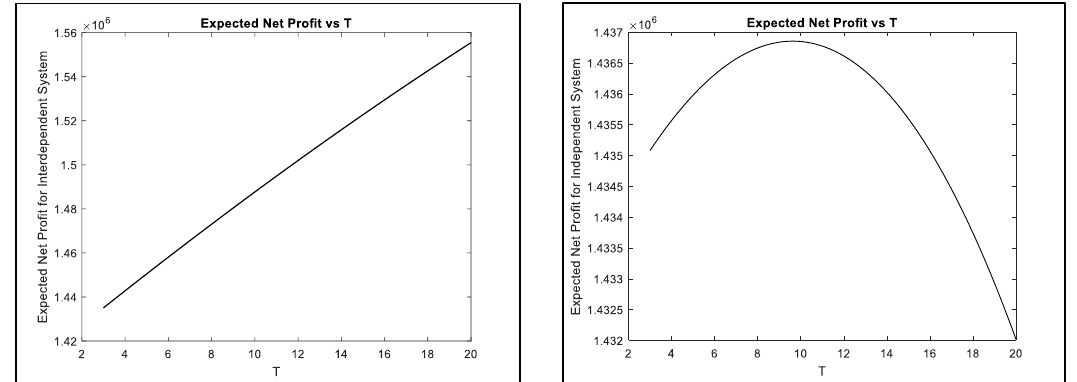
Figure 3. Expected Net Profit versus for Interdependent (Left) System and Independent (Right)